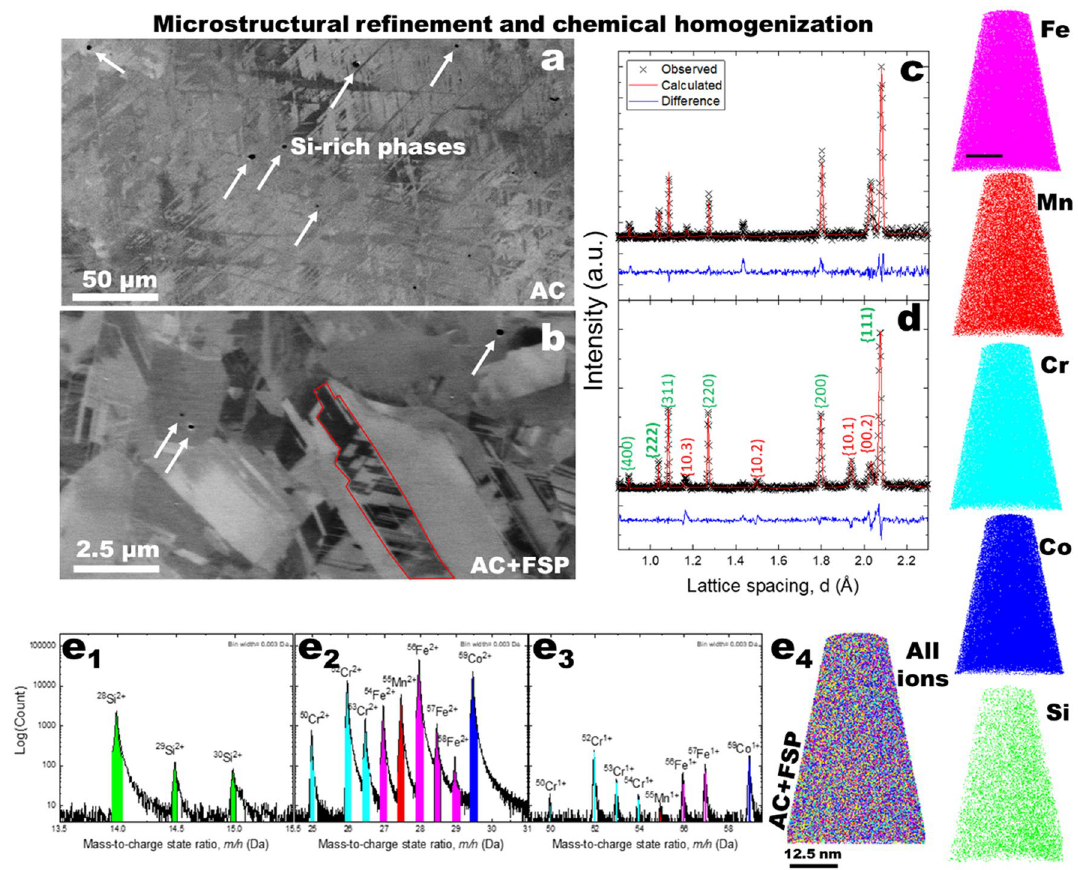
Figure 1. Evaluation of microstructural evolution and chemical homogenization of Fe 40 Mn 20 Cr 15 Co 20 Si 5 alloy before tensile deformation. Secondary electron SEM images of ( a ) as-cast (AC), and ( b ) grain-refine friction stir processed (AC + FSP) conditions demonstrating the microstructure refinement following friction stir processing. Further neutron diffraction traces from the two conditions, ( c ) AC, and ( d ) AC + FSP, conclusively showed the presence of γ-f.c.c. and ε-h.c.p. phases in both the conditions. Peaks labeled green and red for γ-f.c.c. and ε- h.c.p. phases, respectively. Atom probe tomography mass spectra with prominent peaks labeled, including: ( e 1 ) Si ions, transition metal ions in the 2 + charge state and ( e 3 ) transition metal ions in the 1 + charge state. Scale bars in ( a ), ( b ) and ( e 4 ) are 50 μm, 2.5 μm and 12 nm,